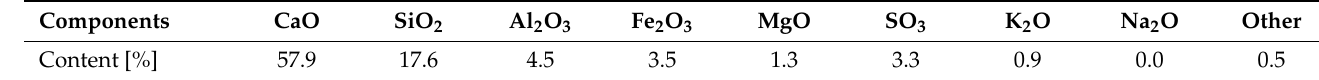
Table 6. Chemical composition of clinker.